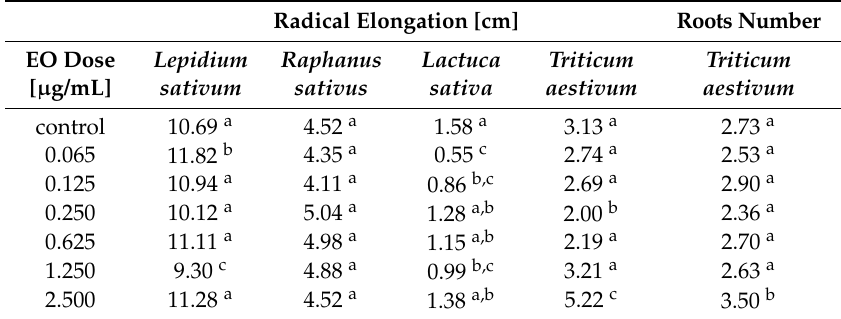
Table 3. Effect of different doses of the essential oil from aerial parts of Heracleum mantegazzianum on the root elongation of four model plant species and roots number of monocotyledoneous